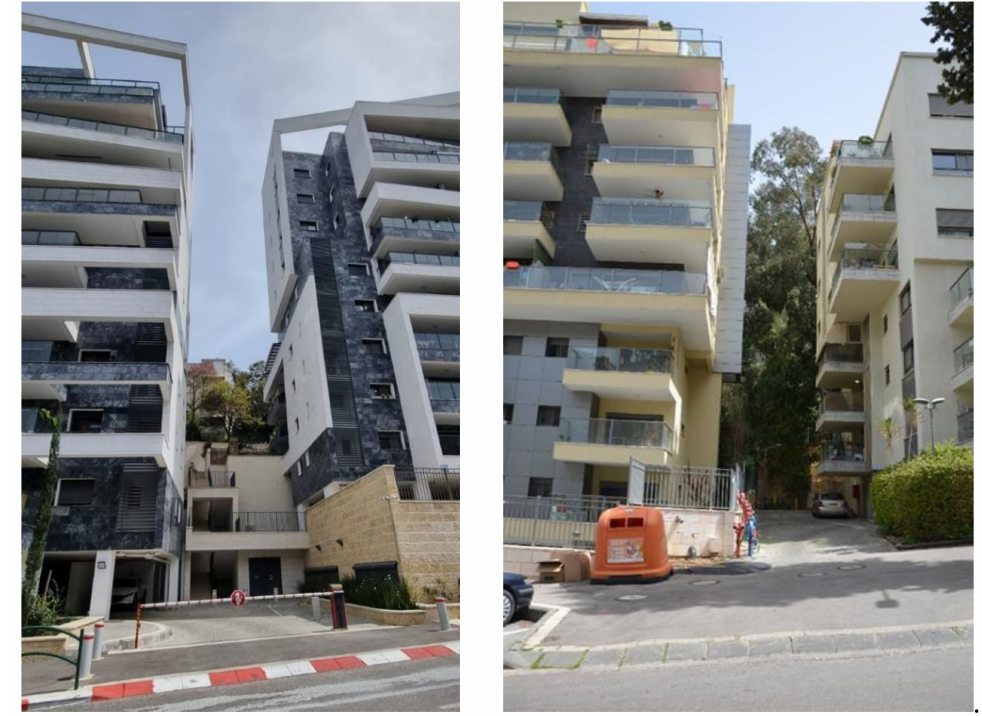
Figure 8. Small gaps between the buildings. Photographed by the authors, 2022. Decreased green areas— many green spaces were converted into residential areas, roads, and parking spots. Consequently, much of the land area has become impermeable, and many trees were uprooted. Note that this outcome is not preordained. Proper care for some of the trees during the reconstruction would have left much of the neighborhood’s natural resources and old character intact, for the enjoyment of future generations (Figure